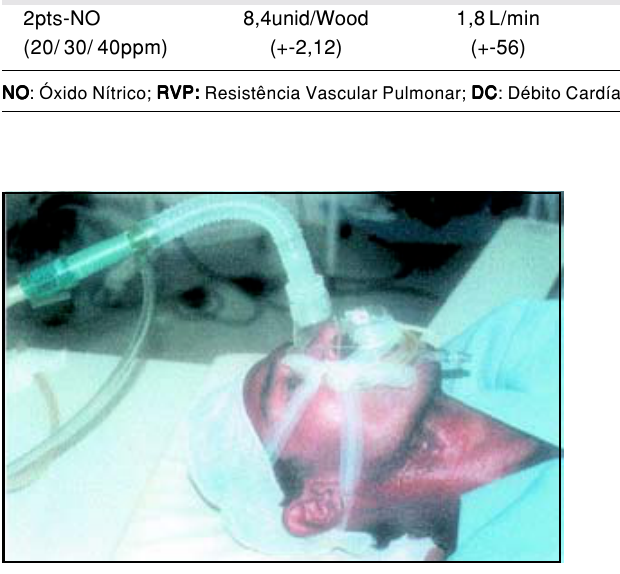
Fig. 5 (cid:150) Circuito inalat(cid:243)rio de NO por mÆscara facial